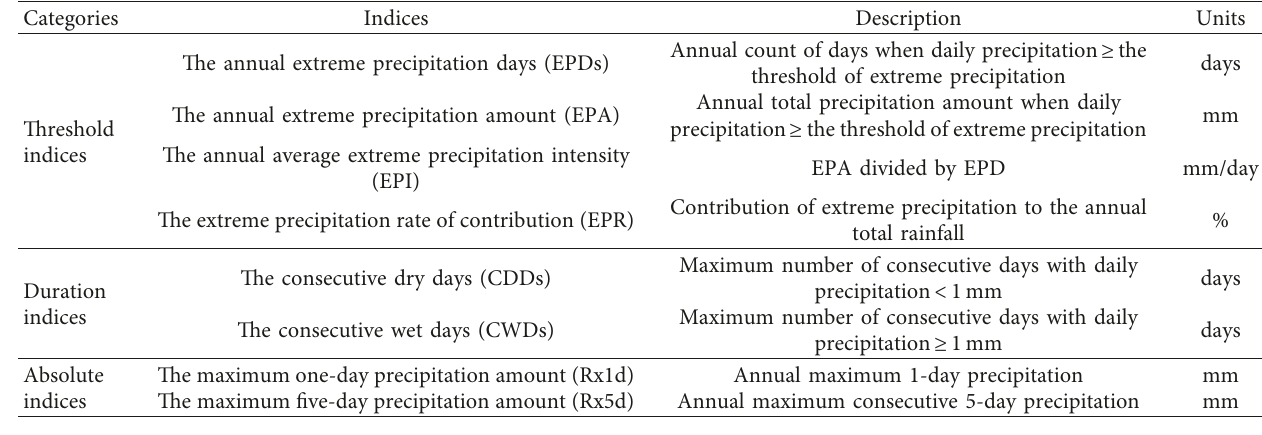
Table 2: Definitions of 8 precipitation extreme indices used in this